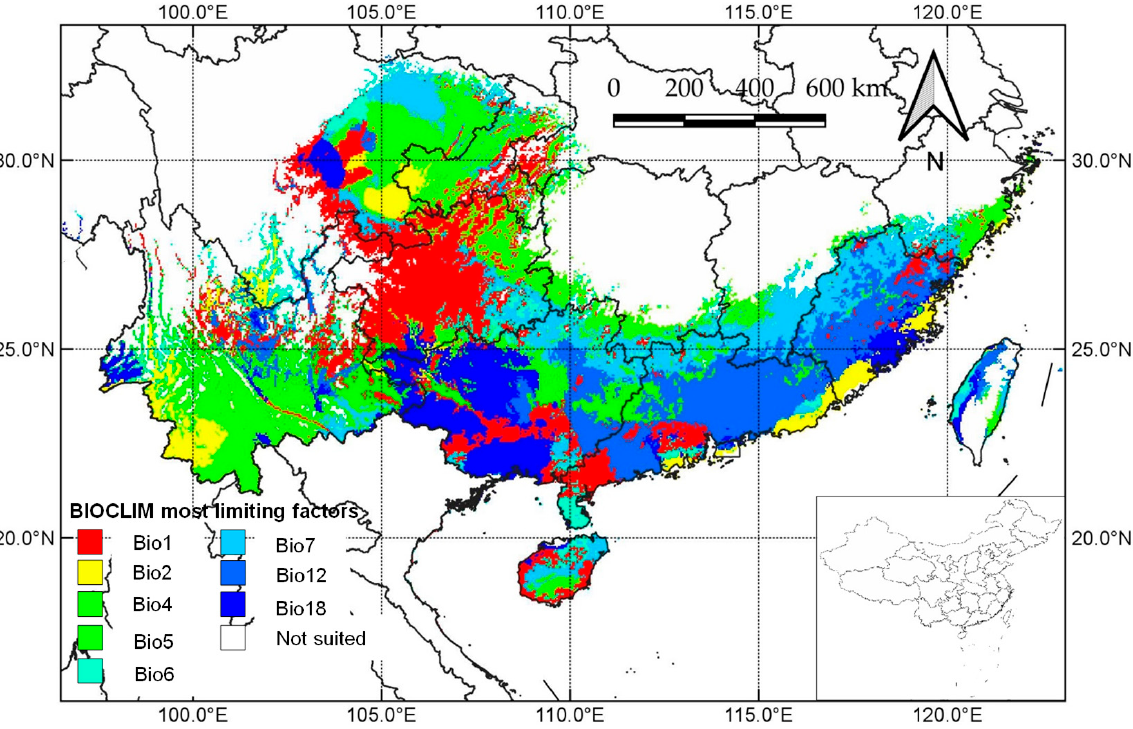
Figure 5. Distribution patterns of the limiting factors for the cultivation of J. mimosifolia. The selected eight bioclimatic variables, shown in different colors, exerted the greatest effect on predicting suitable habitats in the south China region. Refer to Table 1 for the meaning of the bioclimatic variables.